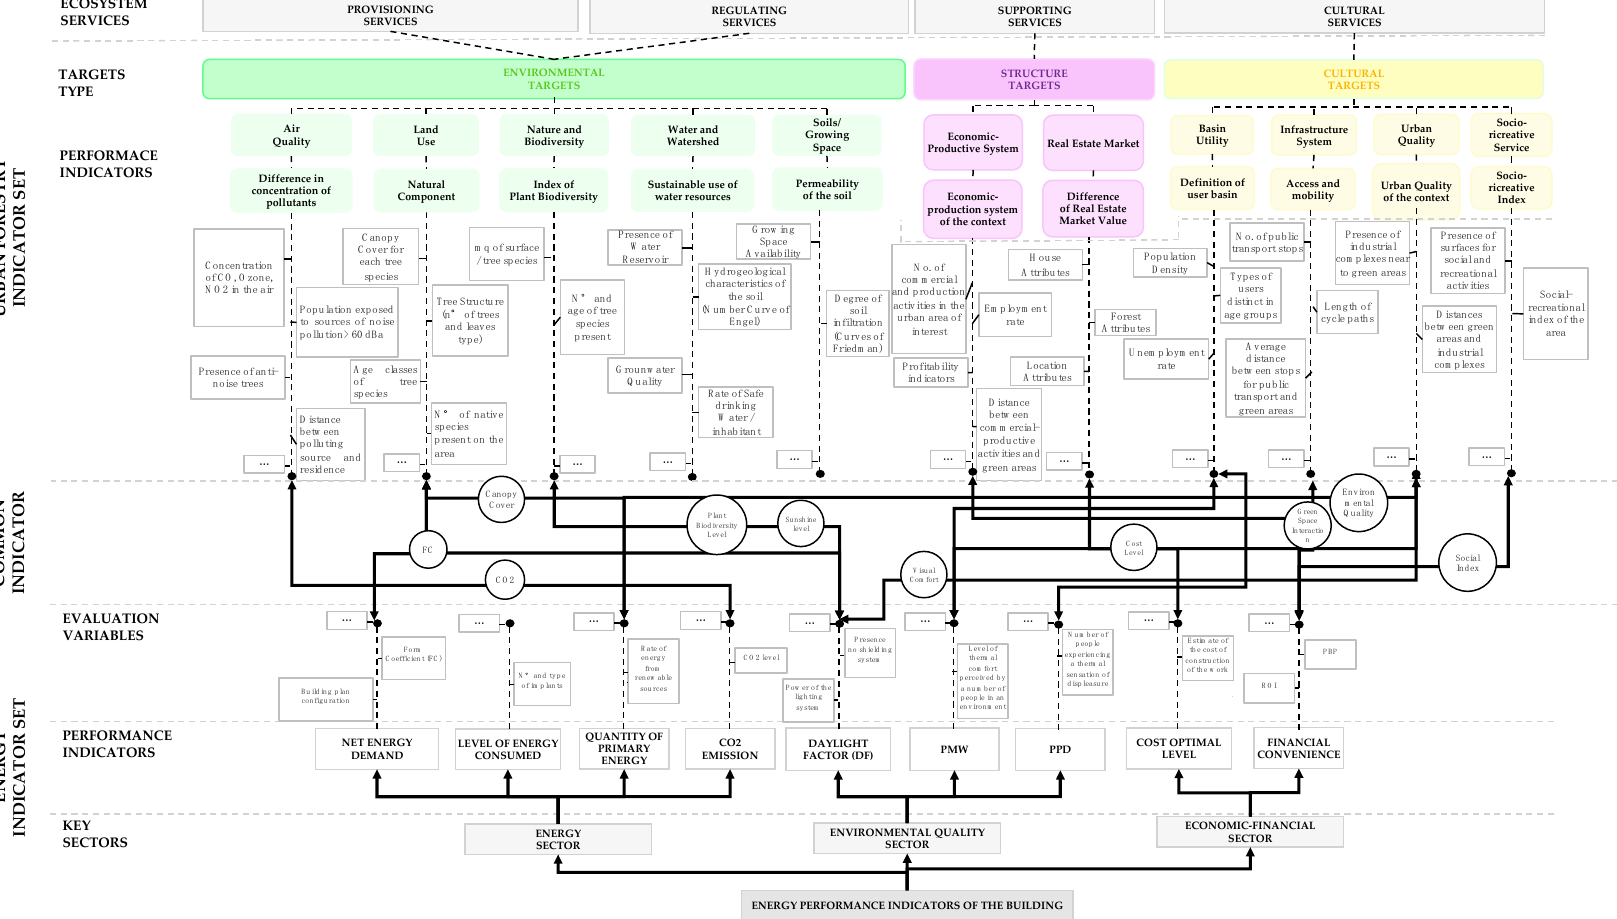
Figure 1. Indicator sets for integrated ecosystem projects.